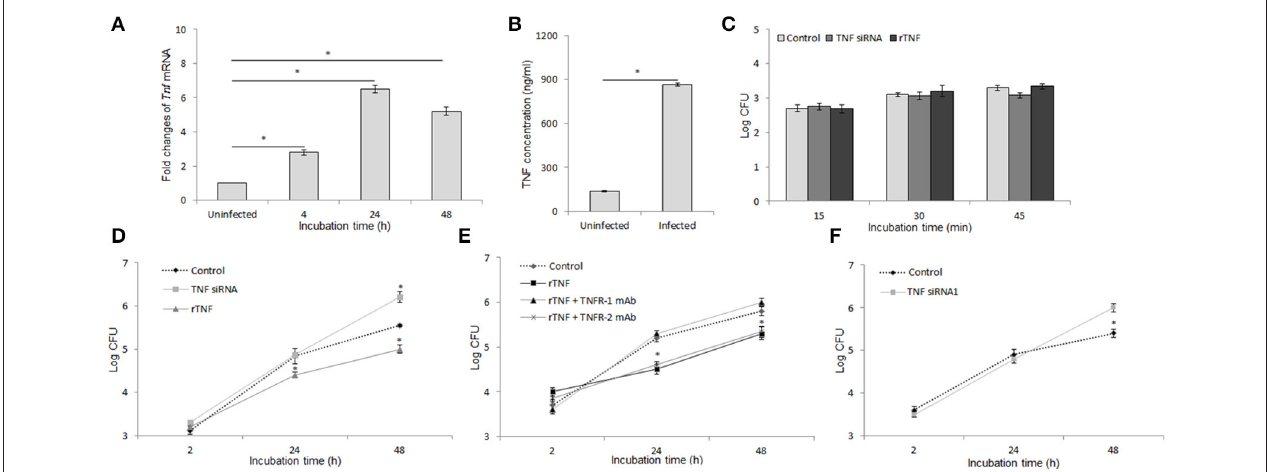
FIGURE 1 | TNF activates antibrucella immunity through binding with TNFR-1. Macrophages infected with B. abortus and the transcriptional and translational profiling of Tnf were examined by qRT-PCR (A) and sandwich ELISA (B) . Bacterial uptake (C) and intracellular growth (D) were evaluated in cells with or without treatment of either TNF siRNA or rTNF. The cells were concomitantly treated with rTNF and either anti-TNFR-1 or -TNFR-2 antibodies, and the intracellular growth of B. abortus was assessed (E) . The validation of TNF suppression was performed by cells treated with TNF siRNA1 and survival rate of bacteria were evaluated (F) . Data represent the mean ± SD of triplicate experiments. Asterisk indicated the significant difference ( P < 0.05).